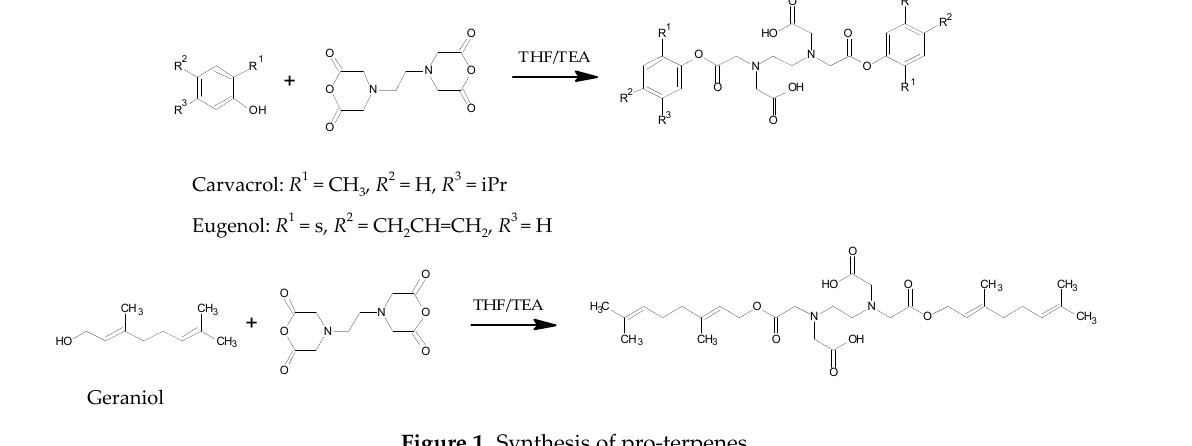
Figure 1. Synthesis of pro-terpenes. Table 1. Melting point and solubility in water of terpenes and pro-terpenes. Compound